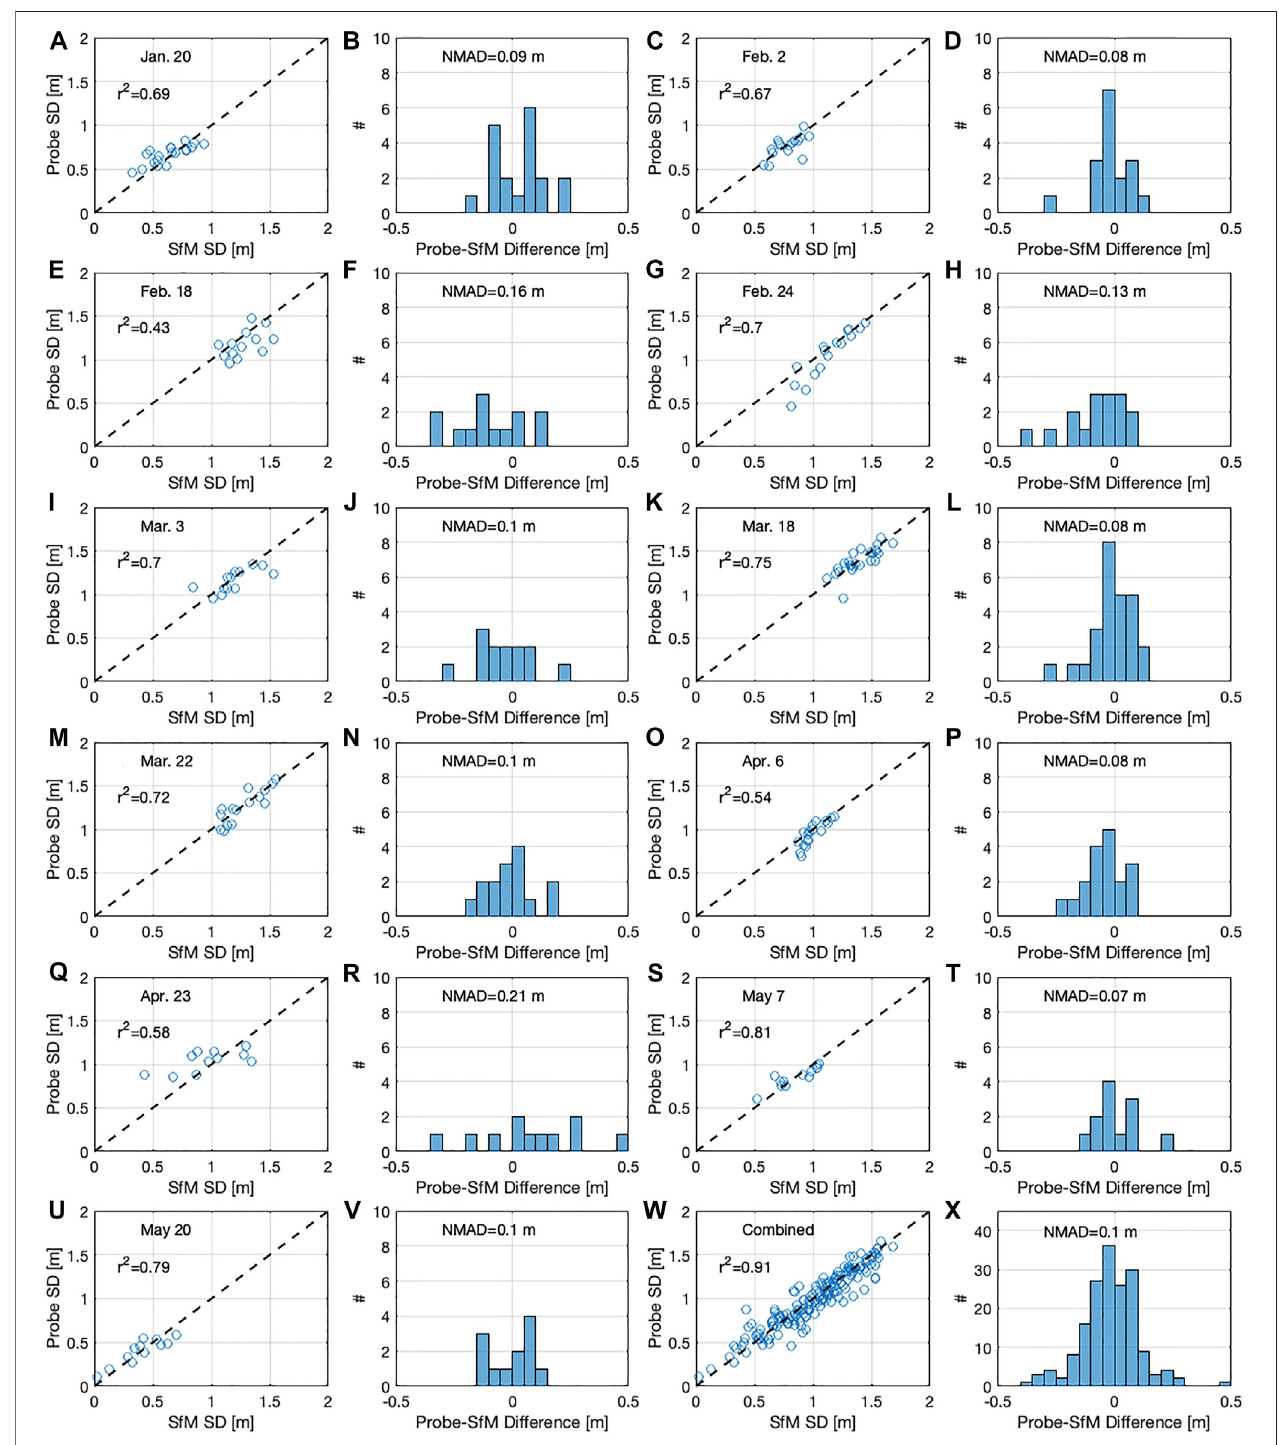
FIGURE 5 | (A,C,E,G,I,K,M,O,Q,S,U,W) Scatterplot of probe measured snow depths (SDs) and SfM measured SDs. (B,D,F,H,J,L,N,P,R,T,V,X) Histograms of snow depth differences between the two independent methods. The NMAD is reported for each comparison.